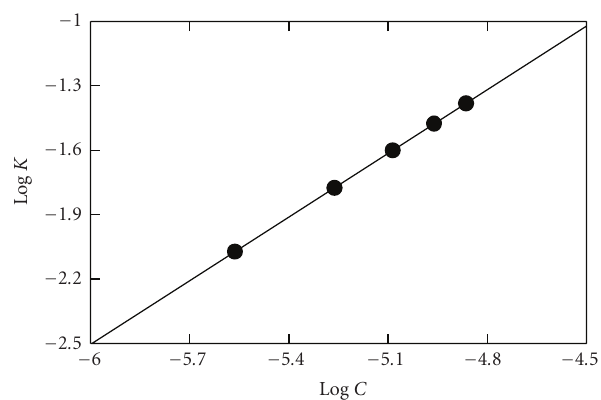
Figure 8: Linear plot for Log C versus Log K for the kinetic reaction of PRX with NQS. C is the PRX concentration (0.3 × 10 − 5 − 2.04 × 10 − 5 M) and K is the reaction rate (second − 1 ). Clark and Lubs bu ff er solution (pH 9): 1 mL; NQS (1.9 × 10 − 2 ): 1 mL; temperature: 25 ± 5 ◦ C.